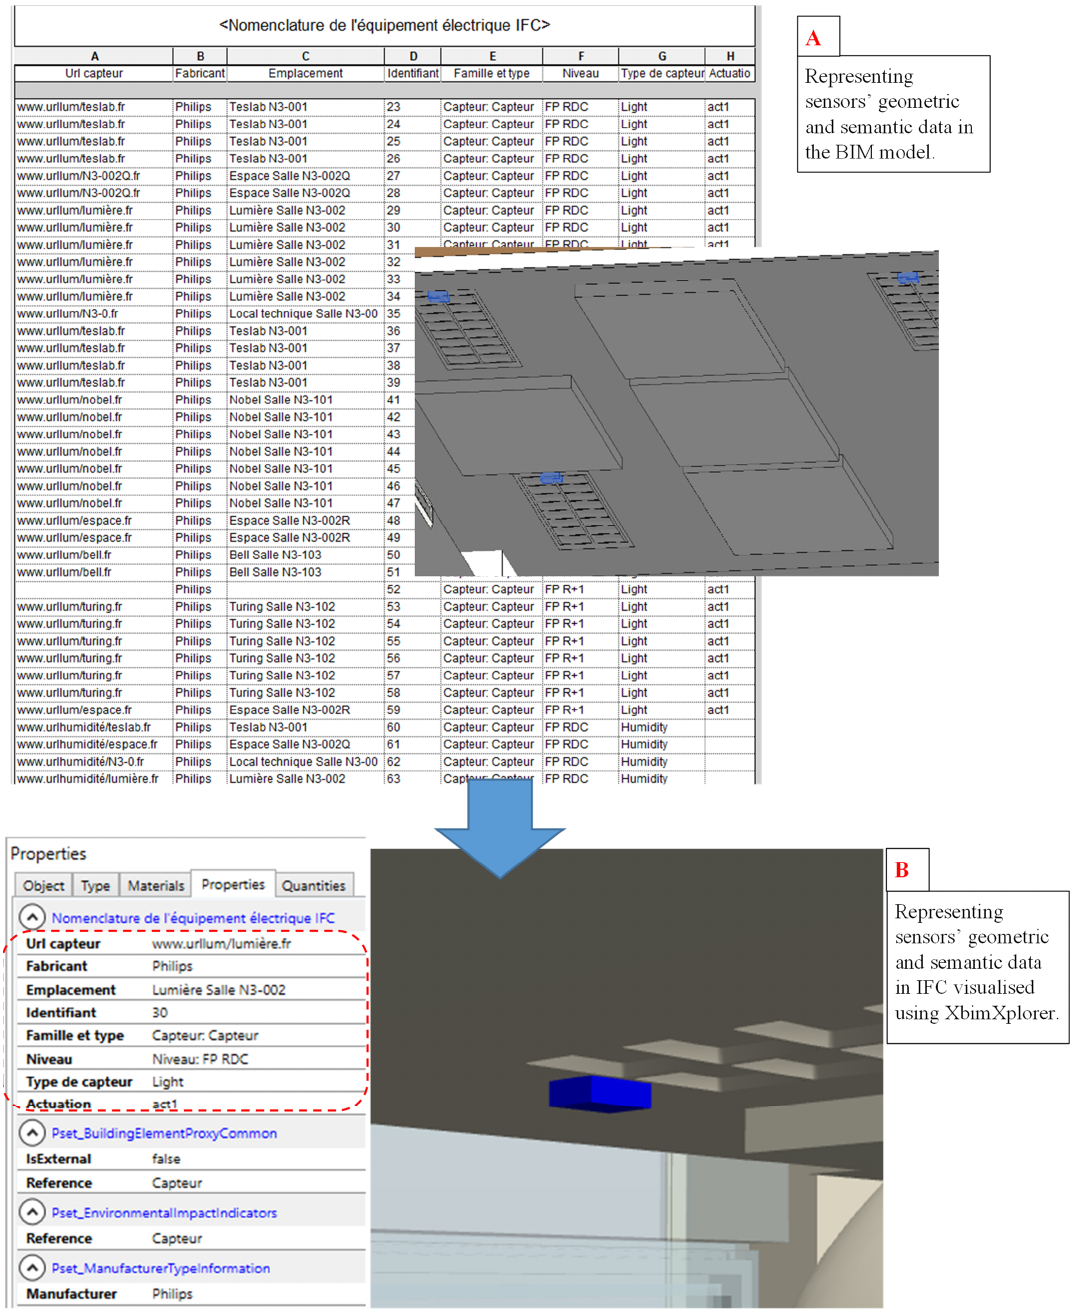
Figure 11. ( A ) N3 ′ s sensor data modelled in a BIM model; ( B ) exported using IFCs and displayed Figure 11. ( A ) N3’s sensor data modelled in a BIM model; ( B ) exported using IFCs and displayed using XbimXplorer. using